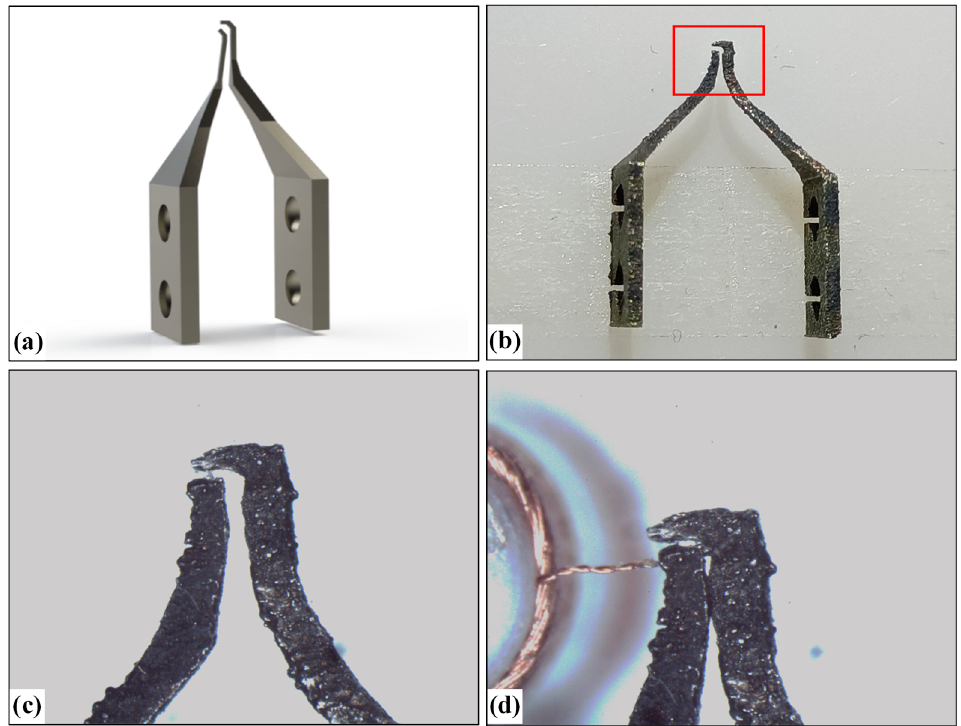
Figure 20. Enveloping-type micro-gripper made of steel: ( a ) 3D model of micro-gripper; ( b ) Picture of micro-gripper; ( c ) Picture of local micro-gripper’s tip corresponding to red box area in ( b ); ( d ) The status that micro-gripper captures a wire.